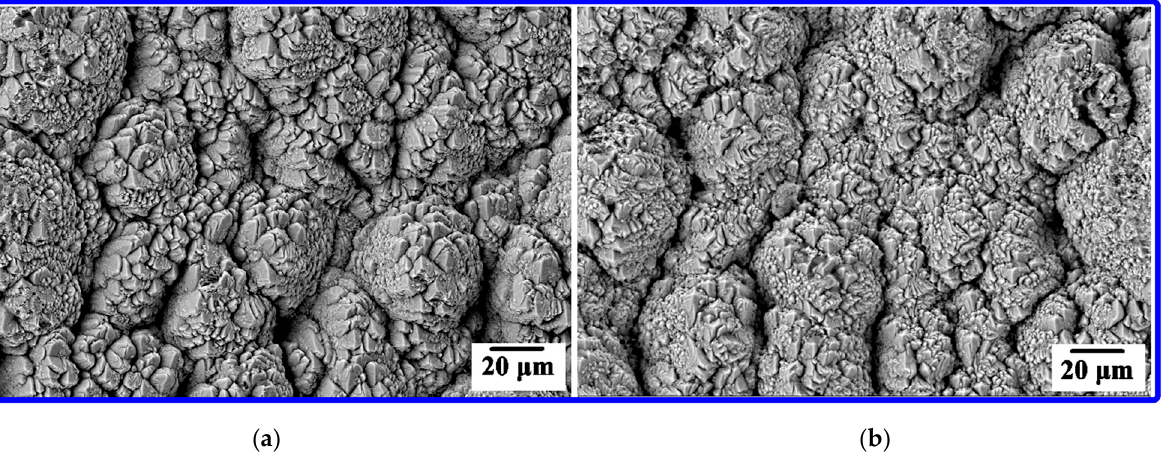
Figure 5. Surface morphology of YSZ coating system after ( a ) four and ( b ) eight thermal cycles without NaCl.